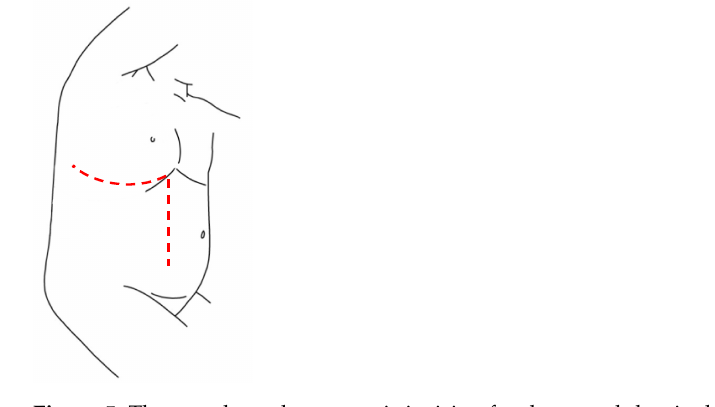
Figure 5. Thoracophrenolaparotomic incision for thoraco ‐ abdominal NBs.